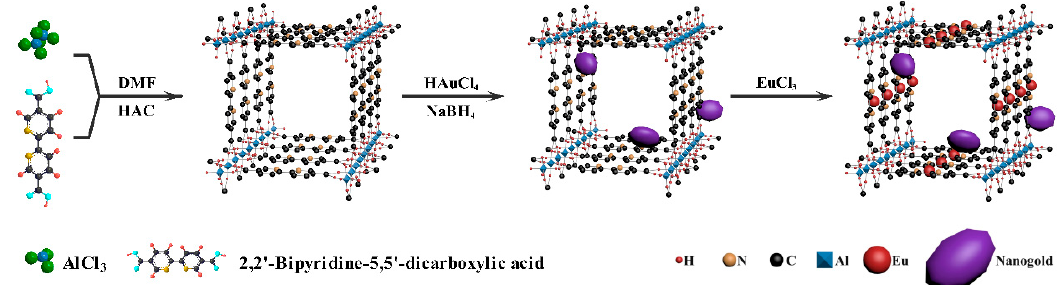
Scheme 1. Schematic diagram of the synthesis of Eu 3+ -MOF-253@Au.